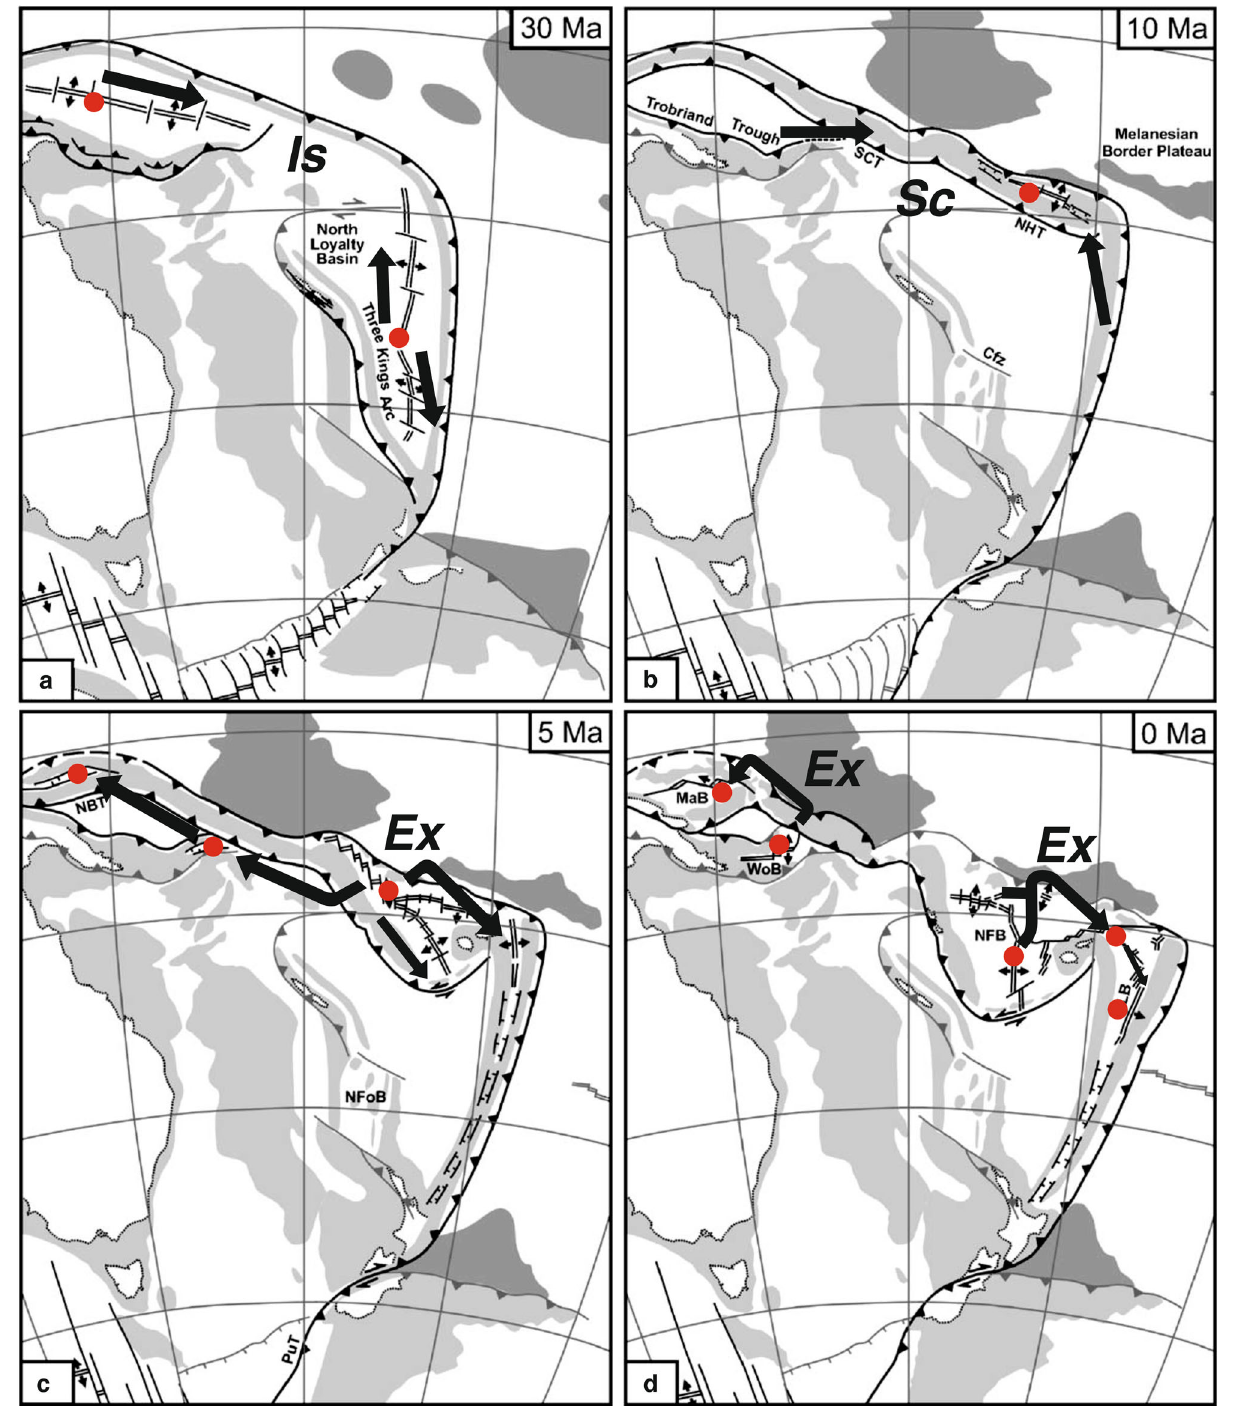
Fig. 9 The Woodlark ridge, a potential biological cornerstone?. Scenario of the Woodlark Ridge ’ s hypothesis as a cornerstone of the vent fauna dispersal in the western Paci fi c using the geotectonic reconstruction model of the Western back-arc basins adapted from Schellart et al. (2006) 16 . a Formation of the Solomon Basin and North Loyalty/South Fiji Basin with two independent ridge systems. b Opening of the northern branch of the North Fiji basin after the fossilization of the South Fiji basin and the opening of the Woodlark ridge about 10 Mya. c Expansion of North Fiji basin together with the opening of the Lau Basin 5 Mya. d Present-days back arc basins with the fi ve hydrothermally active zones, including Futuna. Red dots: active spreading centres, black arrows: putative colonization routes, Is : species isolation phase, Sc : secondary contact, and Ex : population expansion phase. Water column operations . All operations were conducted using a 24-Niskin package, acoustic anomalies were identi fi ed, analyzed and attributed to various bottle rosette frame onto which were mounted a Seabird CTD 911 + , two Turbi- scatterers (large biological echoes, sea fl oor re fl ections … ). Anomalies were con- dimeters (Seapoint Turbidity Metres), a pH sensor (AMT GmBH) and an Eh sidered as attributable to hydrothermal plumes if they were connected to the sensor (AMT GmBH), as well as an altimeter for sea fl oor detection. The Seasave sea fl oor and reproducible over time, i.e., detected several times at the same software provided by Seabird Electronics was used for real-time data acquisition location. COMMUNICATIONS EARTH & ENVIRONMENT| (2022) 3:64 |https://doi.org/10.1038/s43247-022-00387-9|www.nature.com/commsenv